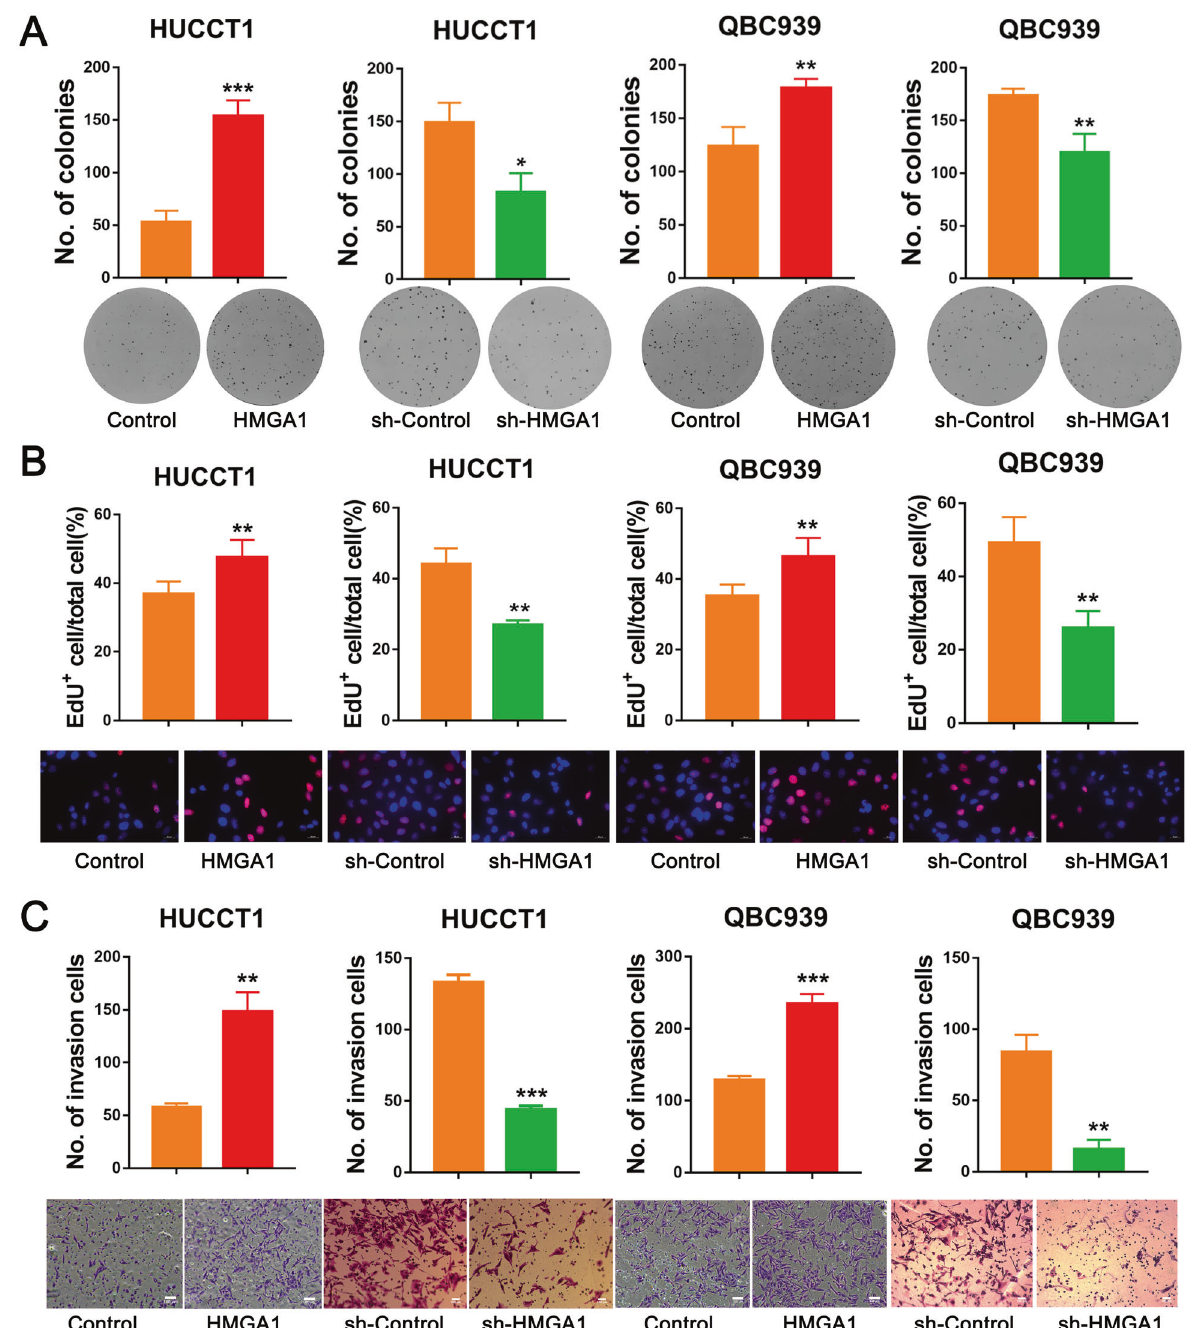
Fig. 2 HMGA1 promotes the proliferation and invasion of CCA cells. A , B The effect of HMGA1 on the proliferation of CCA cells was examined by clonogenic ( A ) and EdU ( B ) assays of CCA cells with HMGA1 overexpression or knockdown ( n = 3 biologically independent samples). C Matrigel invasion data showing that overexpression of HMGA1 signi fi cantly enhanced the invasion capacity, whereas knockdown of HMGA1 decreased the invasion potential of CCA cells ( n = 3 biologically independent samples). The P -value was obtained by Student ’ s t test. The results represent the mean ± S.D. of three independent experiments. * P < 0.05, ** P < 0.01, *** P < We performed a transwell assay and found that HMGA1 over- expression signi fi cantly enhanced the invasion potential, while knockdown of HMGA1 led to reduced invasion compared with control cells (Fig. 2C and Fig. S1E). We next assessed the potential role of HMGA1 in tumor growth by establishing a subcutaneous xenograft model using HUCCT1 ( n = 5) and QBC939 cells ( n = 6) with HMGA1 knock- down or overexpression. As a result, knockdown of HMGA1